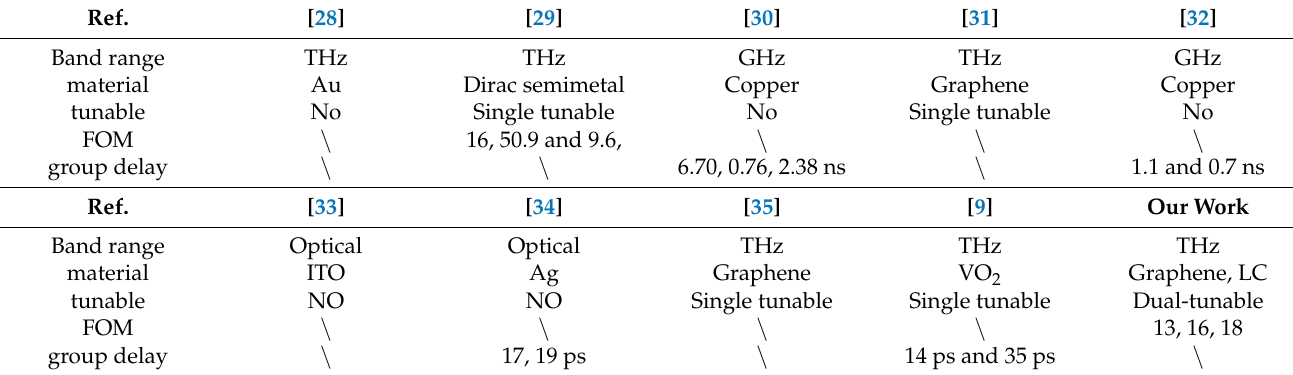
Table 1. Comparison of performance reported in various multiband A-EIT metamaterial.